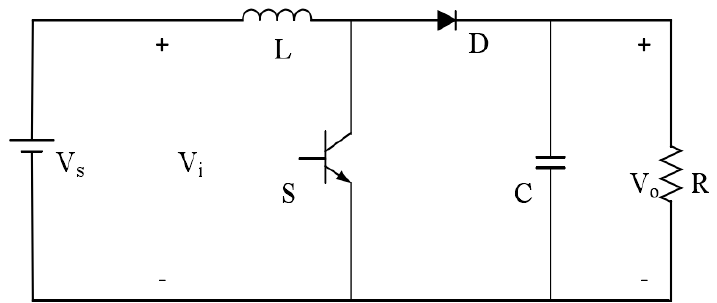
Figure 13. Boost transform circuit.